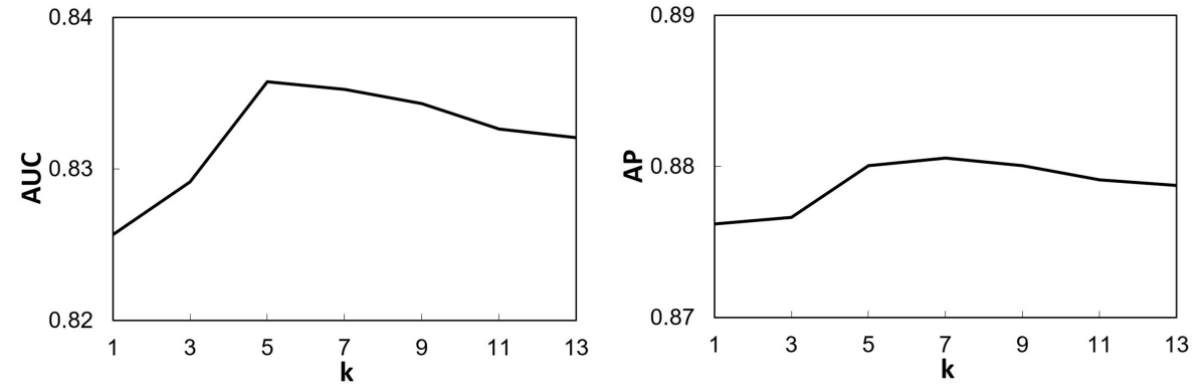
Figure 5. Variation in the area under the receiver operating characteristic curve (AUC) and average precision (AP) with the number of neighbors k in k-nearest neighbor.